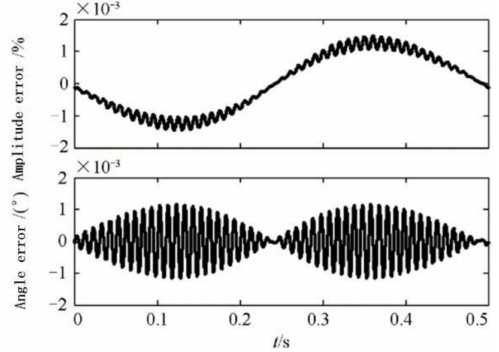
Figure 8. Phasor measurement error under the condition of amplitude oscillation.